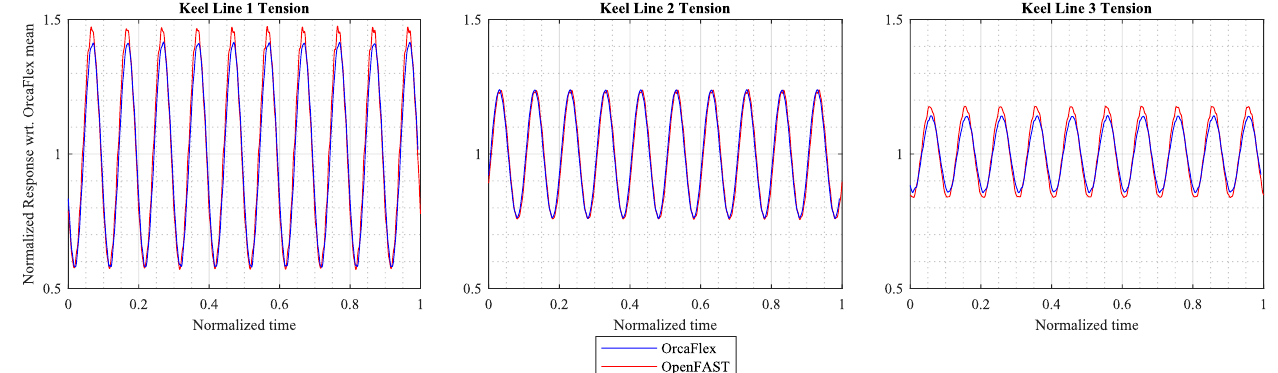
Figure 9. Comparison of the keel line tension in a regular sea state and with a steady wind load. Only keel line 1–3 is presented because line 4–6 is identical to 1–3.